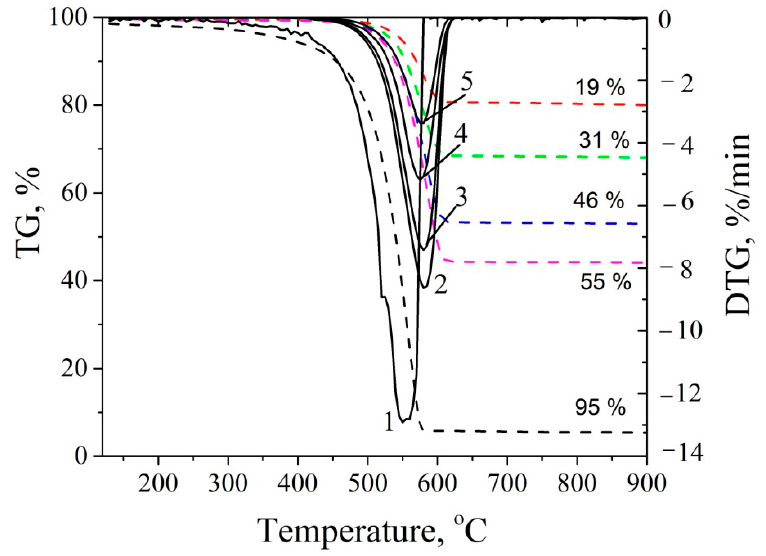
Figure 3. TG and DTG curves of biochars: 1—TC (control), 2—TBC-3, 3—TBC-2, 4—TBC-1, 5—TBC-0.5.